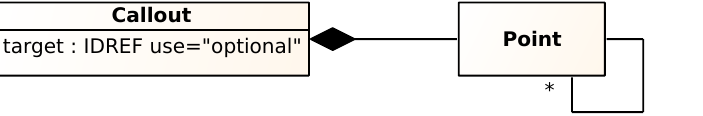
Figure 19: A UML representation of the Callout class for the Systems Biology Graphical Notation - Markup Language. See Section 2.1 for conventions related to this